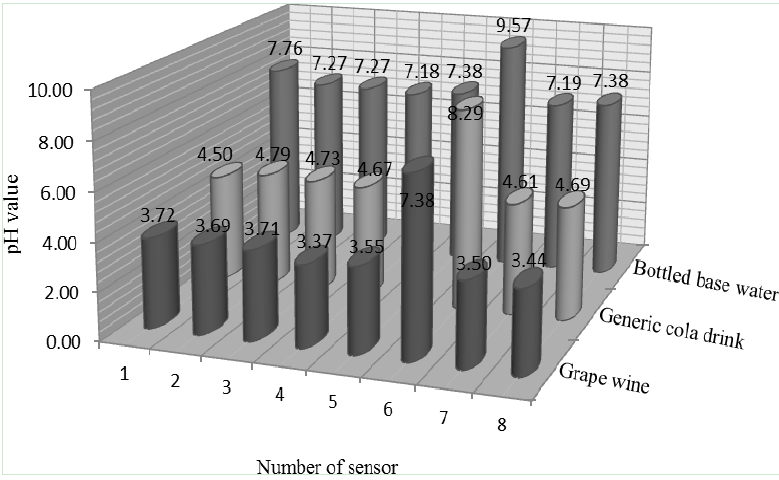
Figure 9. Average of pH measured data of each sensor in grape wine, generic cola drink and bottled